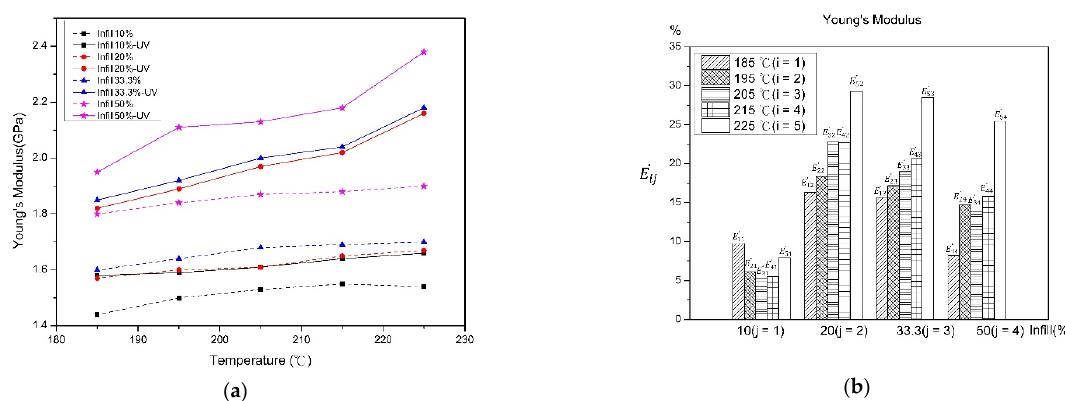
Figure 3. Before and after UV curing ( a ) Young’s modulus ( b ) rate of change.